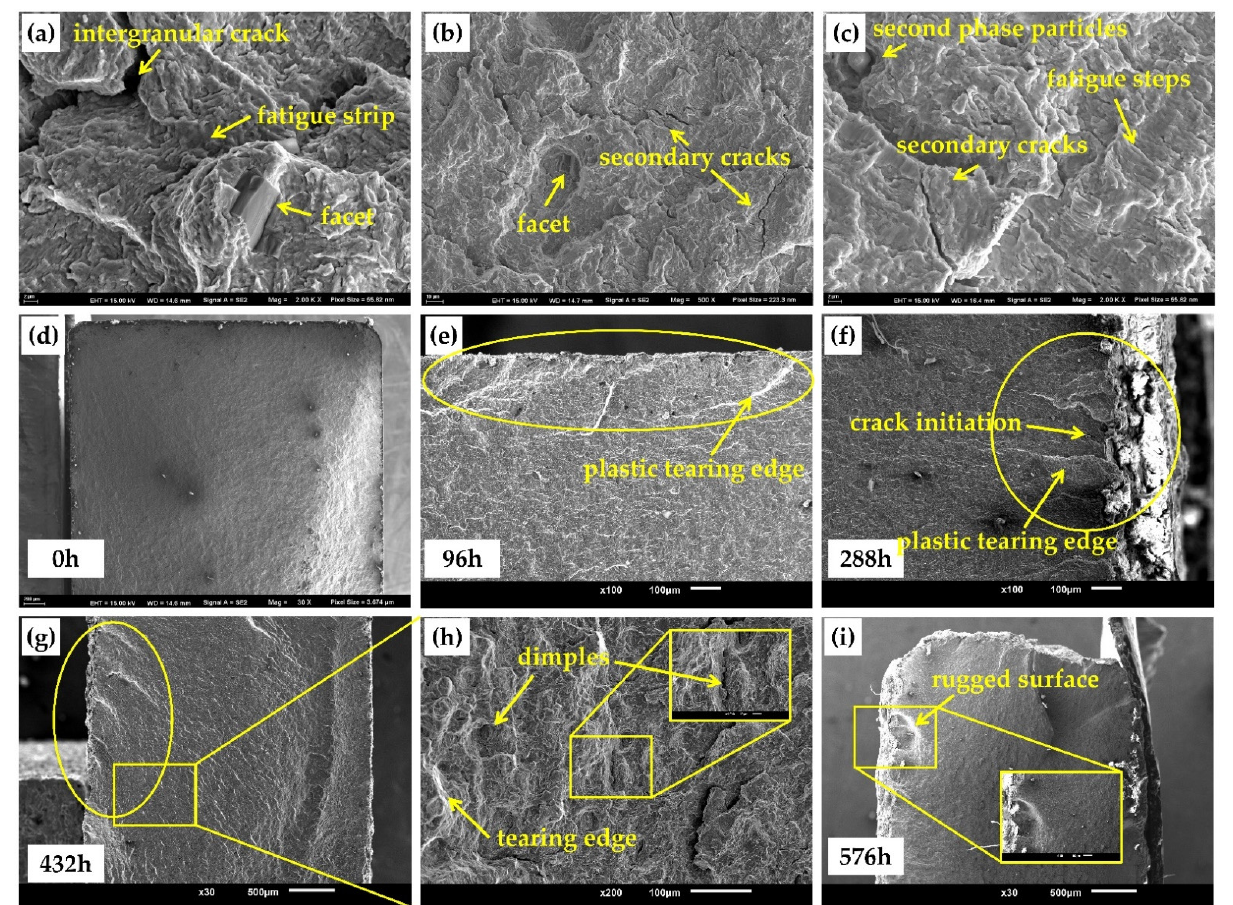
Figure 11. The microscopic morphology of the fatigue crack propagation region: ( a – c ) micromorphological characteristics; ( d ) blank; ( e ) 96 h; ( f ) 288 h; ( g ) 432 h; ( h ) yellow box of ( g ); ( i ) 576 h.